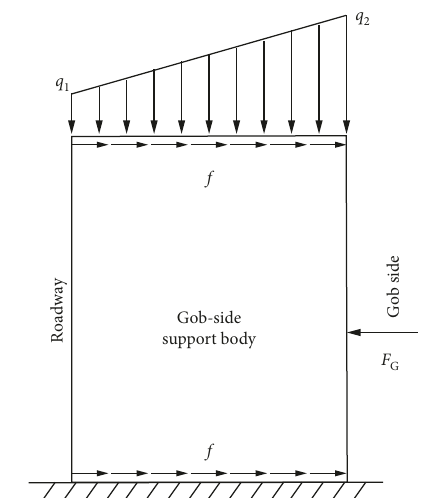
Figure 10: Stress analysis of the gob-side support